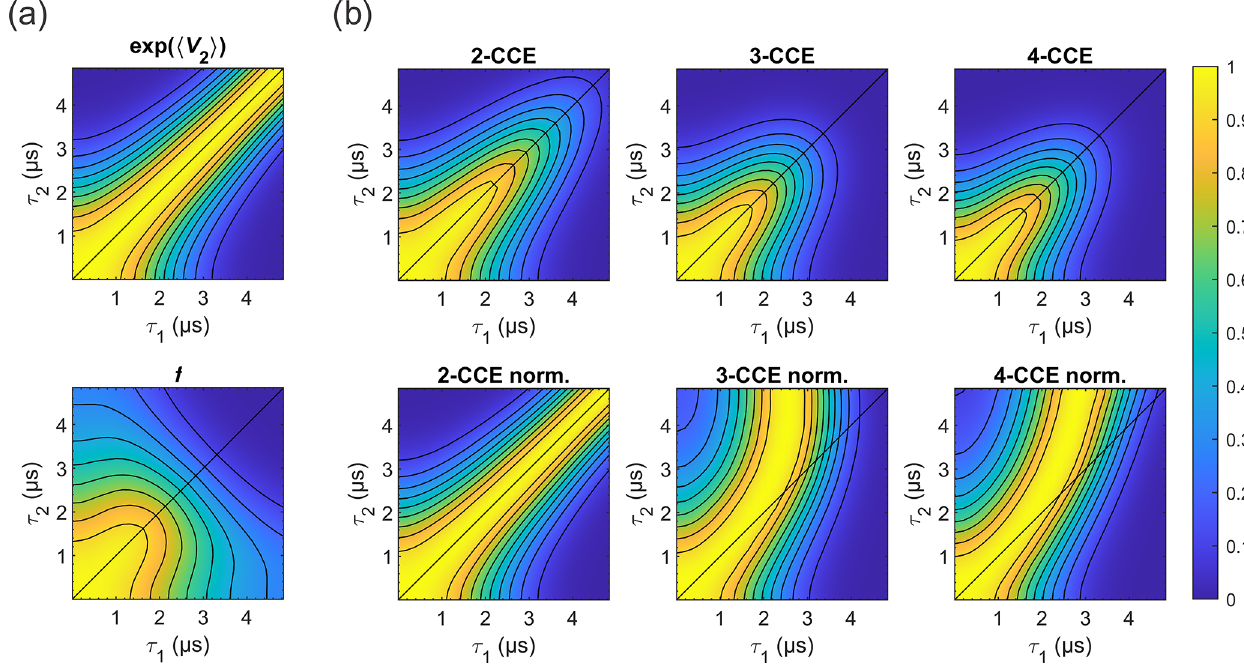
Figure 10. Simulated refocused echo decay of 3-maleimido-proxyl. (a) Factorization of the four-cluster decay into a second-order term in b nm (top) and all higher-order terms (bottom). (b) Simulated refocused echo decays at two-, three-, and four-cluster level (2-CCE, 3-CCE, and 4-CCE; top), with the corresponding slice-wise normalized decays (bottom). For this simulation, a single orientation of the radical was